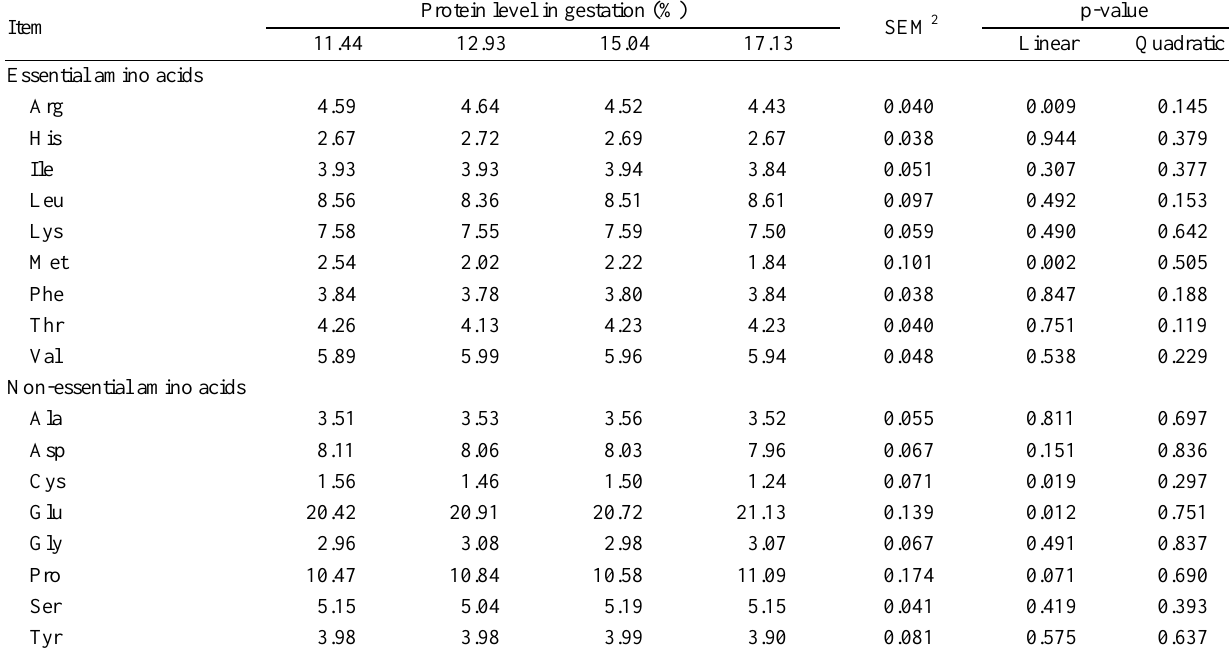
Table 8. Effect of CP levels in gestation diets on amino acid composition (g/100 g milk protein) in milk of primiparous sows at 21 d